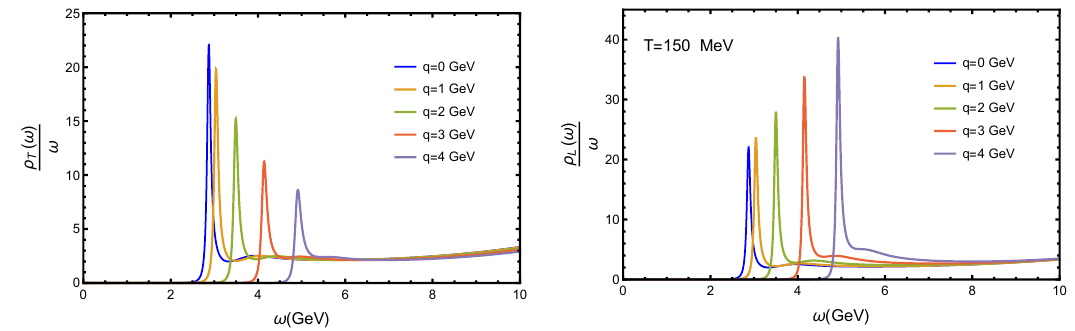
Figure 3 . Spectral Function for charmonium with di(cid:11)erent values of linear momentum at (cid:12)xed value of temperature.